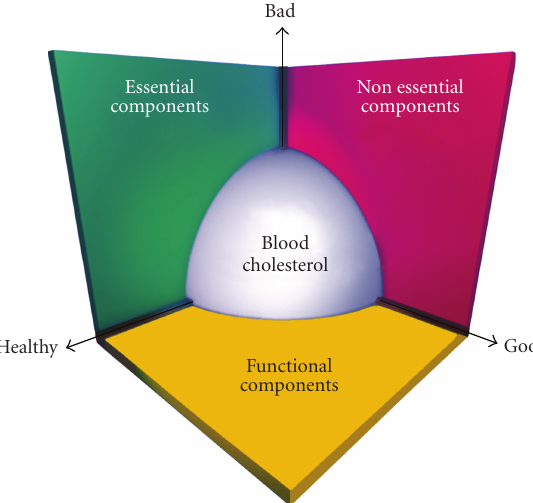
Figure 1: Blood cholesterol as a Marker for Holistic Health.